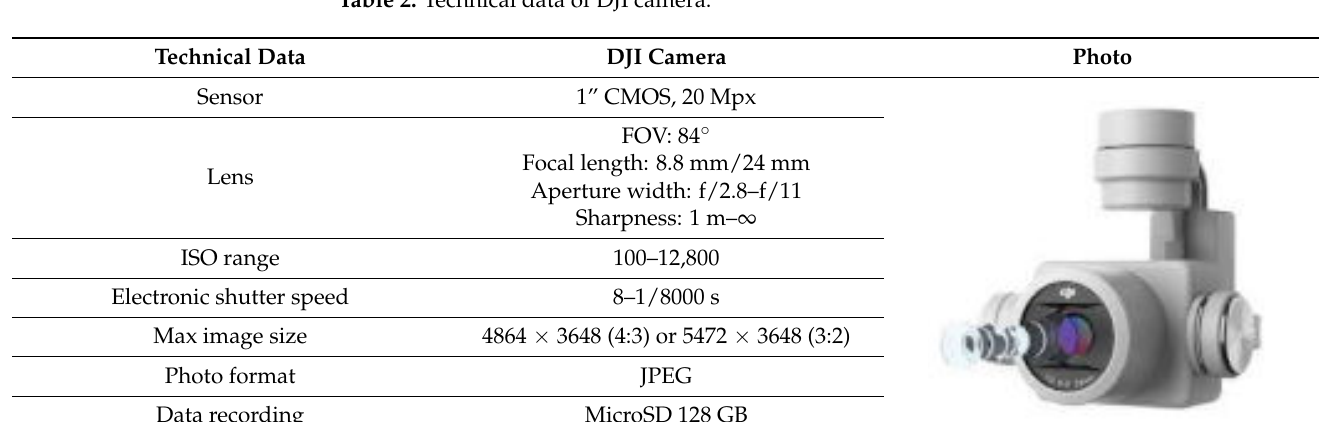
Table 2. Technical data of DJI